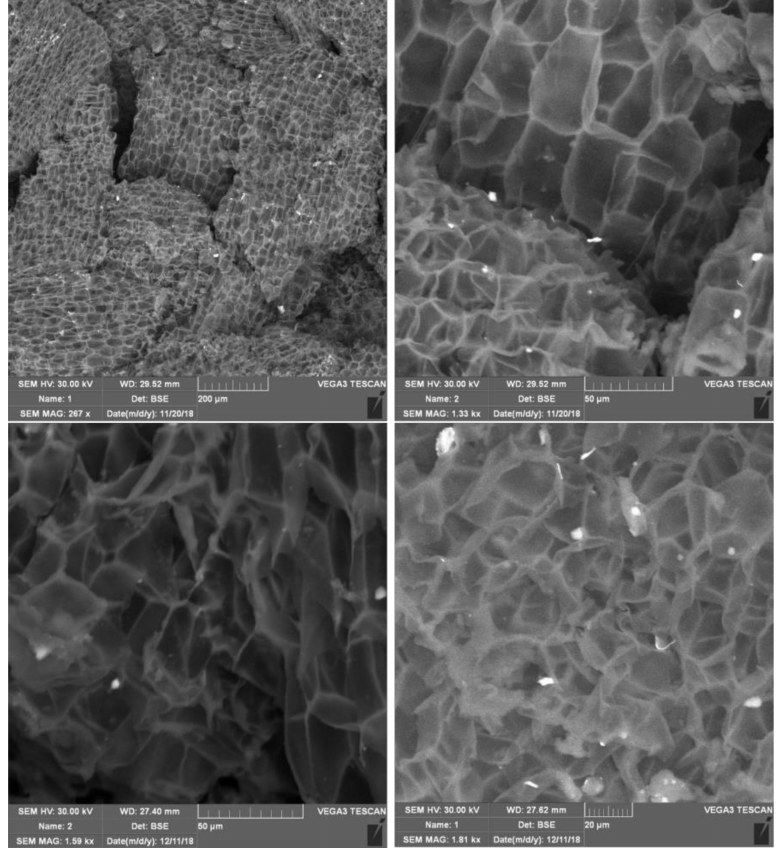
Figure 3. Microstructure of GNP sample with 1 wt.% graphene nanoplates: magnitude of 267 ( left ) and 1330 ( right ). Top row: specimen before test—magnitude of 267 ( left ) and 1330 ( right ), lower row: specimen after dynamic tests—magnitude of 1590 ( left ) and 1810 ( right